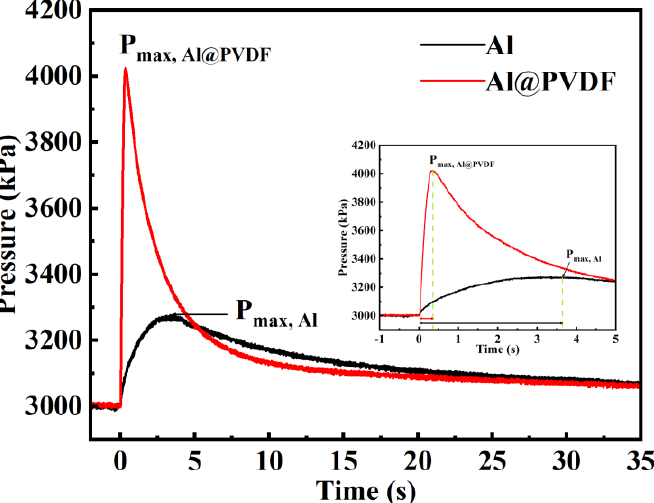
Figure 9. Comparison of the pressure change as a function of time. Inset: enlarged P-T curves in the time range of 0 – 5 s.